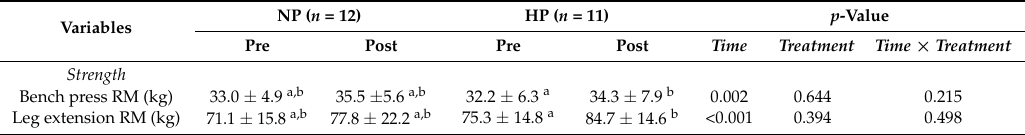
Table A1. Strength tests values according to moments and